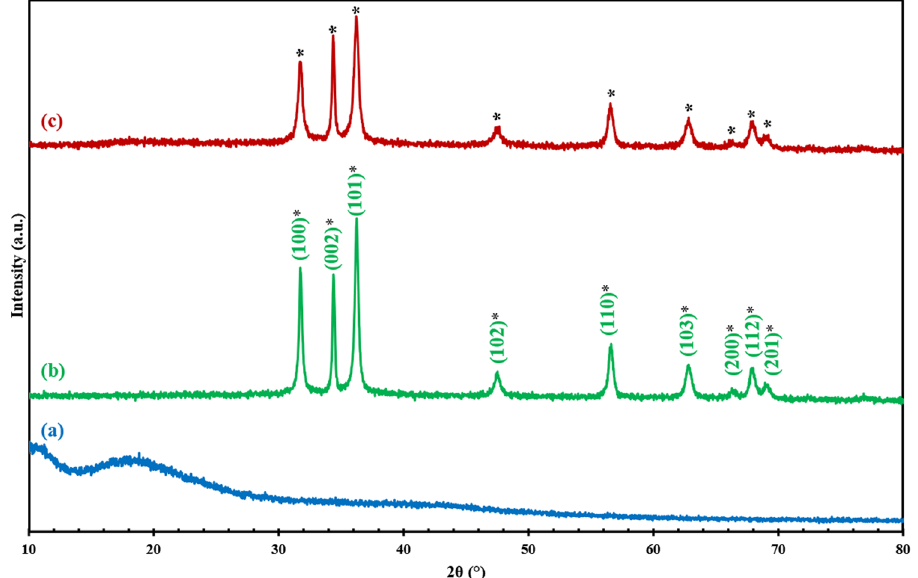
Figure 3: XRD di ff ractograms of ( a ) SMEAF, ( b ) ZnO Chem , and ( c ) ZnO SMEAF .